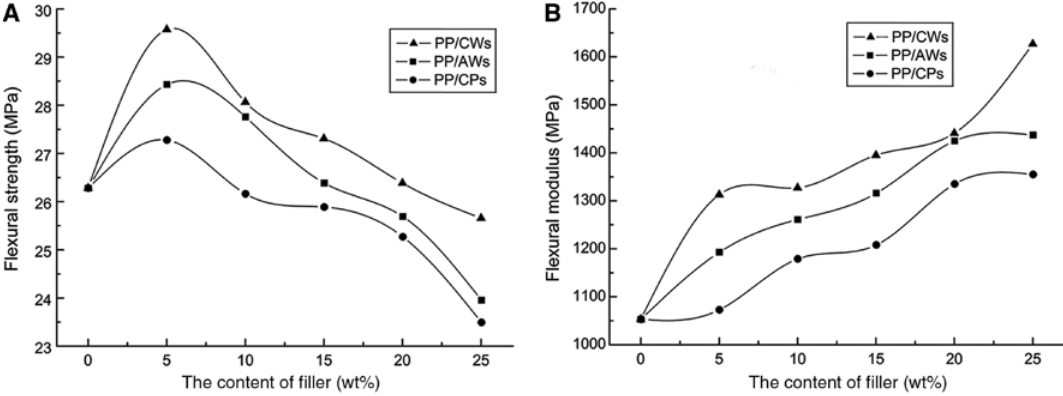
Figure 3: The results of flexural properties for PP/CWs, PP/AWs, and PP/CPs composites: (A) flexural strength, (B) flexural